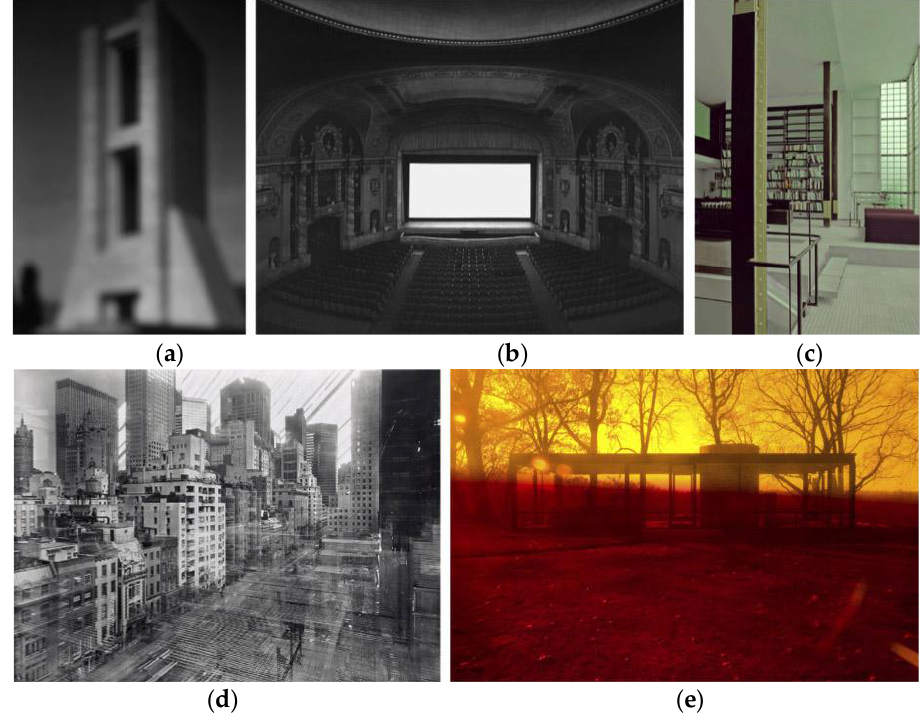
Figure 3. ( a ) Hiroshi Sugimoto, Architectures (Monumento Sant’Elia), 1998; ( b ) Hiroshi Sugimoto, Theatres (U.A. Walker), 2000; ( c ) James Welling, Maison de Verre , 2009; ( d ) Michael Wesely, Open Shutter (The Museum of Modern Art‚ New York), 9 August 2001–2 May 2003; ( e ) James Welling, Glass House , 2009.